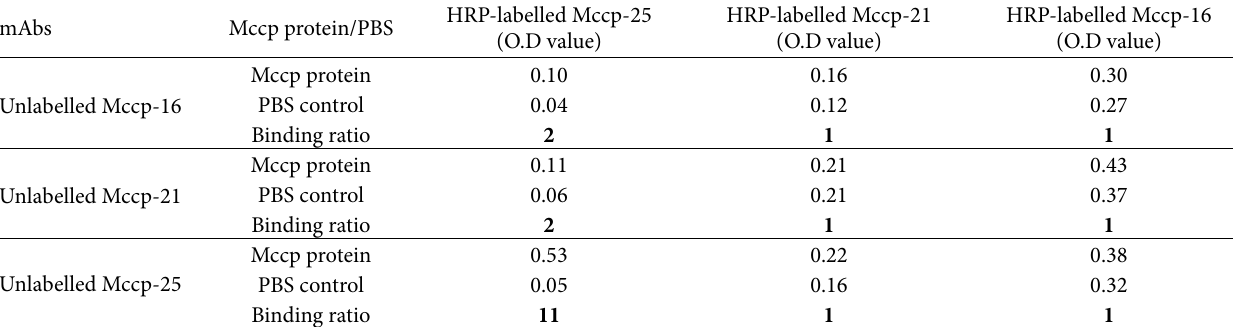
Table 2: Combinations of unlabelled mAbs and HRP-labelled mAbs for ELISA on Mccp